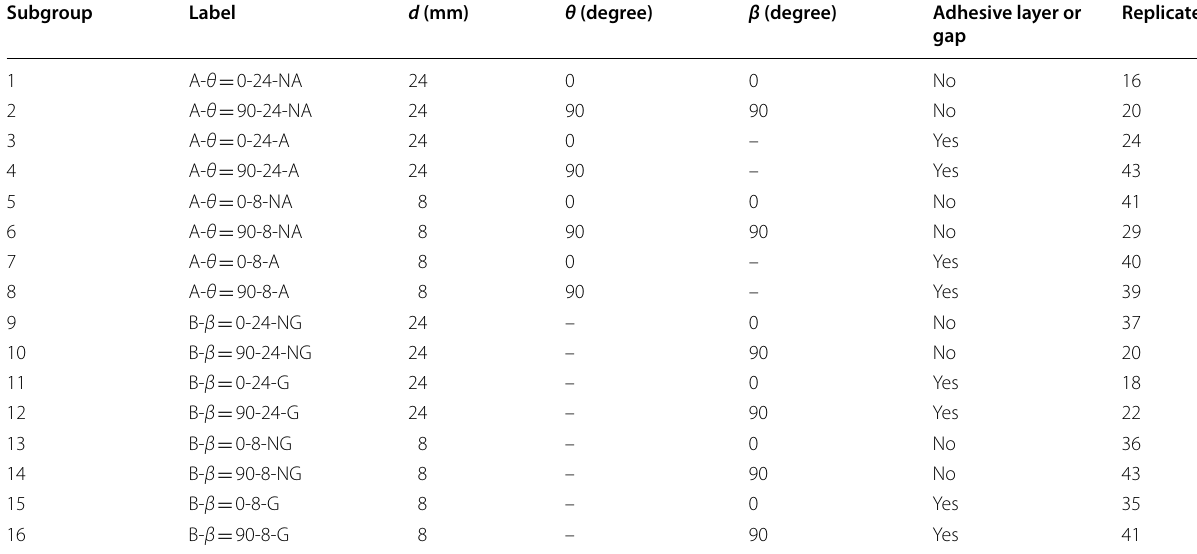
Table 1 Details of cubic CLT embedment specimens